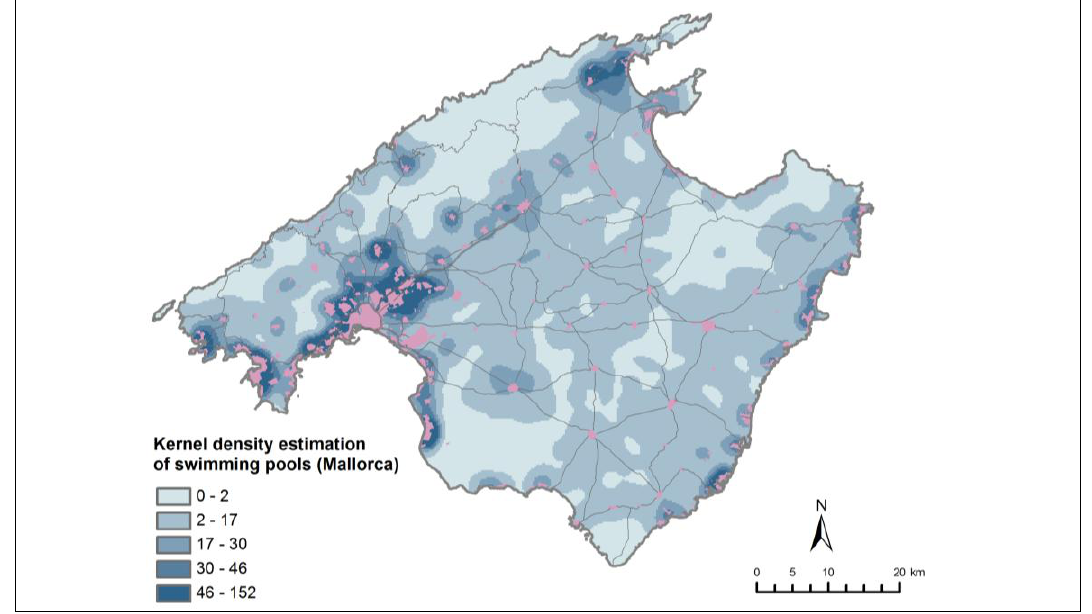
Figure 7. Results of kernel density analysis on the swimming pools associated with human dwellings usable as residential houses in Majorca. Data source: Own calculations based on the Topographic Map of the Balearic Islands (2006), used with permission from Sitibsa S.A., Palma